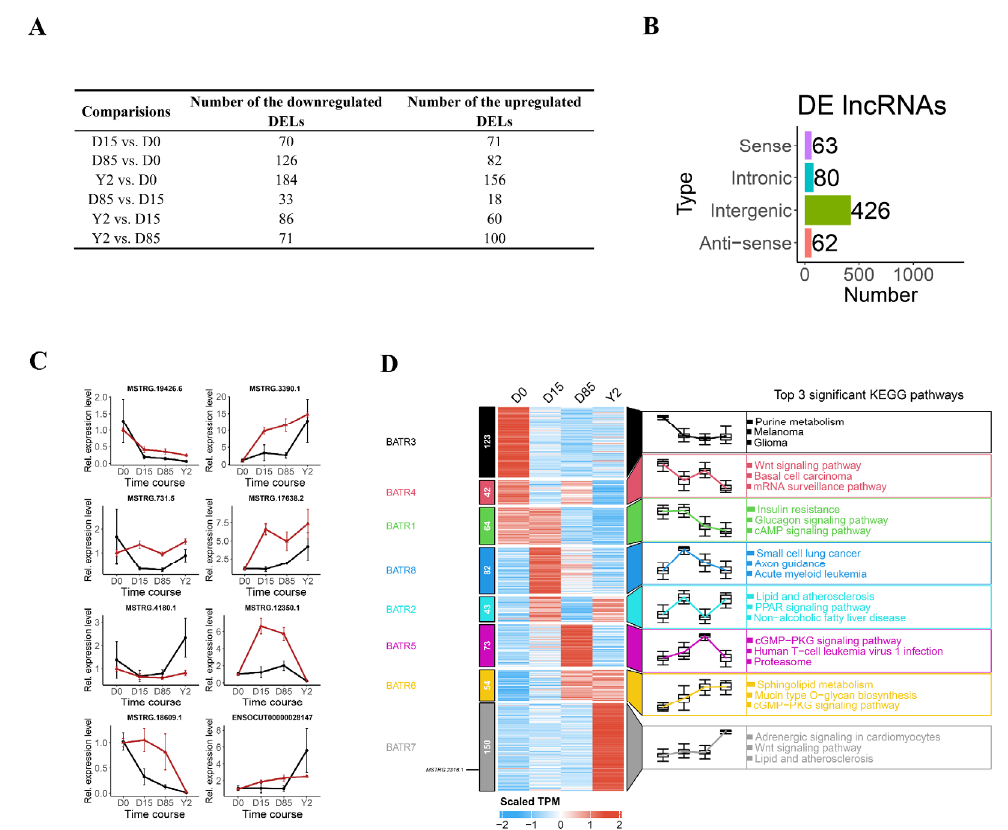
Figure 3. Dynamic changes and pathway enrichment of lncRNAs during the iAT whitening. ( A ) Counts of DELs in different comparisons. ( B ) The distribution of DELs in different lncRNA types. ( C ) Validation of DELs using qRT-PCR. The red line represents ssRNA-seq TPM values and the black line represents relative expression levels of qRT-PCR. The expression was normalized to the ACTB gene and D0. The data shows the means of three independent experiments. Two technical replicates were set for one individual experimental replicate. ( D ) Heatmap analysis of DELs based on k-means clustering method and KEGG pathway enrichment. The clusters are marked by different annotation blocks with different colors and the numbers of DELs in different clusters are showed in the left annotation blocks of the heatmap. The expression patterns of DELs in different clusters are shown in corresponding box-plots and top 3 significantly enriched KEGG pathways are